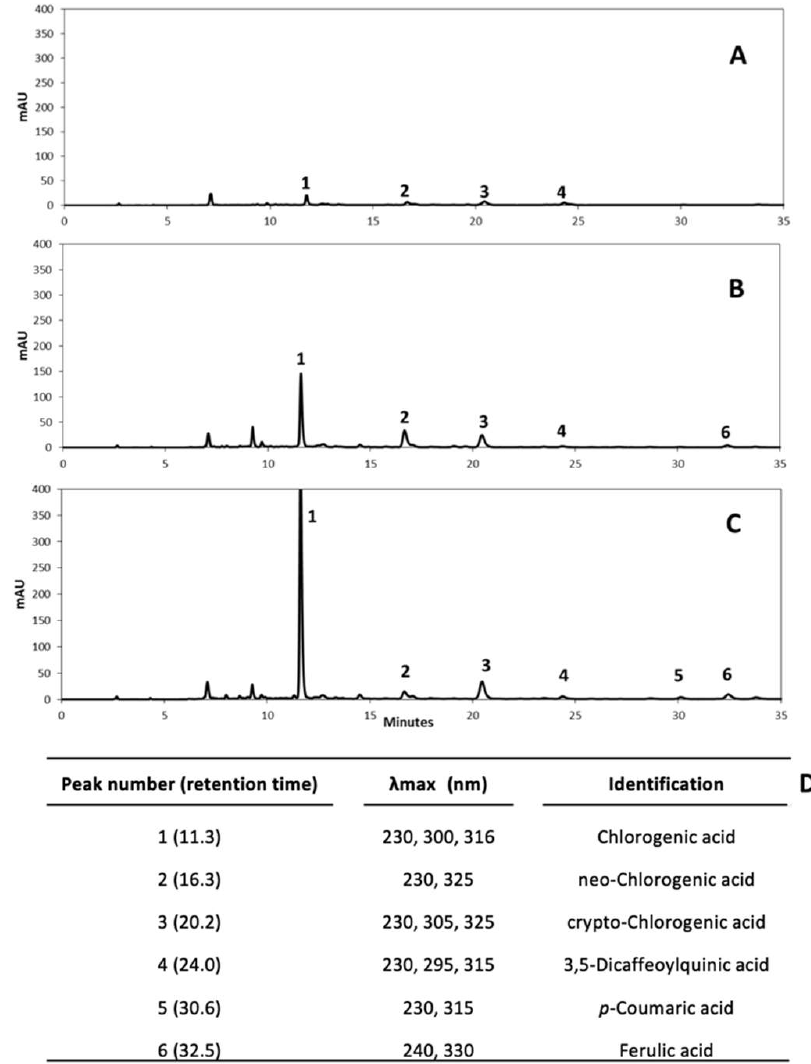
Figure 1. Typical HPLC–PDA chromatograms (shown at 320 nm) from methanol extracts of pie-cut potatoes before ( A ) and after 96 h of storage at 10 ◦ C ( B ), and 20 ◦ C ( C ). Identification of individual phenolic compounds in the potatoes was based on their retention time and spectra characteristics ( λ max) when compared with authentic standards ( D